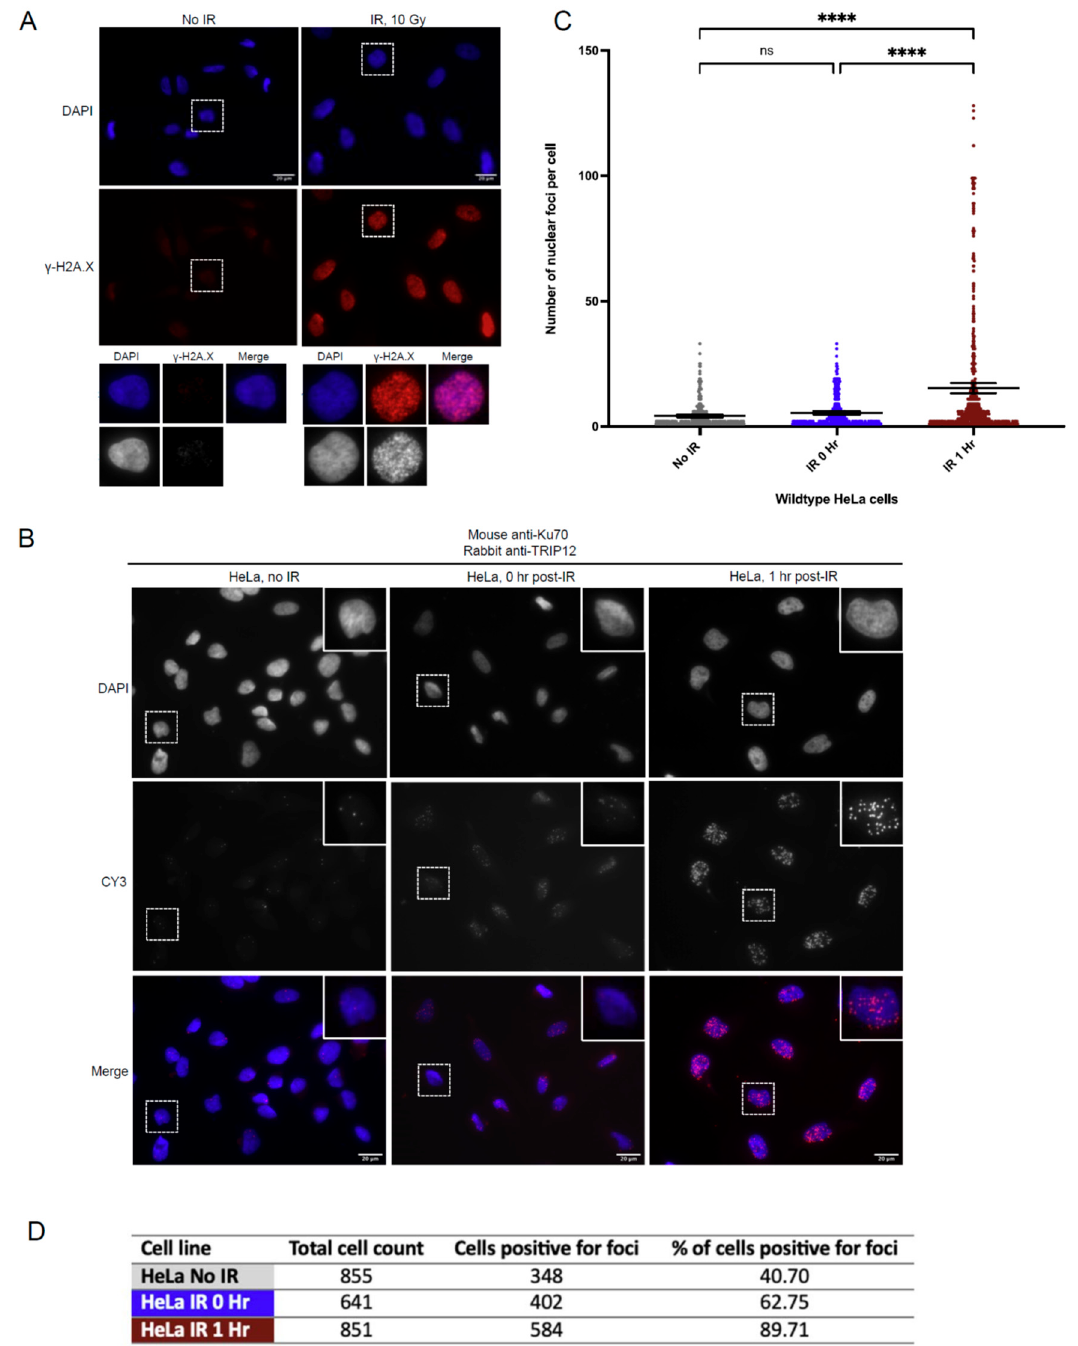
Figure 5. PLA with endogenous Ku70 and TRIP12 in HeLa cells treated with IR to produce DSBs: ( A ) indirect immuno fl uorescence testing HeLa cells treated with 10 Gy IR for the presence of DSBs using a speci fi c antibody to detect γ -H2AX. Images were taken at 40× magni fi cation. Below, cropped enlargements of individual cells are shown either colored or in grey-scale; ( B ) representative images of PLA conducted with endogenous Ku70 and TRIP12 in HeLa cells without IR (no IR), with 10 Gy IR and fi xed immediately (IR 0 h), or with cells fi xed 1 h post-10 Gy IR (IR 1 h), visualized with immuno fl uorescence microscopy. Images were taken at 40× magni fi cation with the white line rep- resenting 20 µm. Insets show enlargements of individual cells; ( C ) PLA quanti fi cation of the number of nuclear foci per cell was determined using ImageJ. The average number of nuclear foci are de- picted as bar graphs and calculated for a minimum total of 600 cells for each condition from four technical replicates for each of three separate experiments or biological replicates; only cells positive for foci are plo tt ed. The bars represent the mean with 95% con fi dence intervals indicated. The “ns”